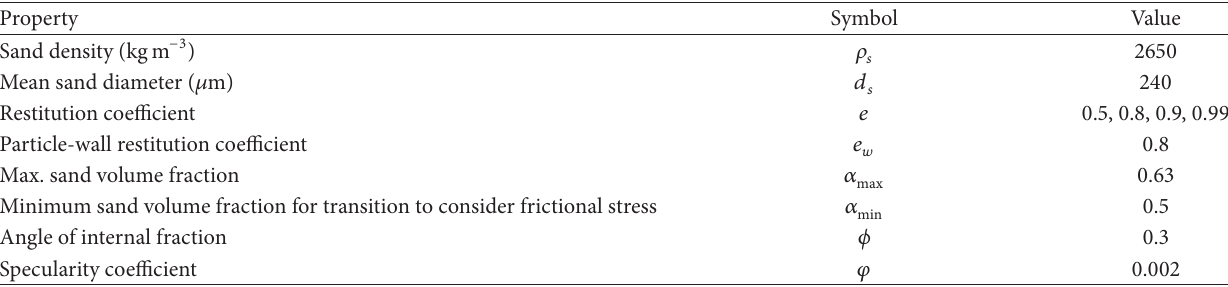
Table 2: Modeling